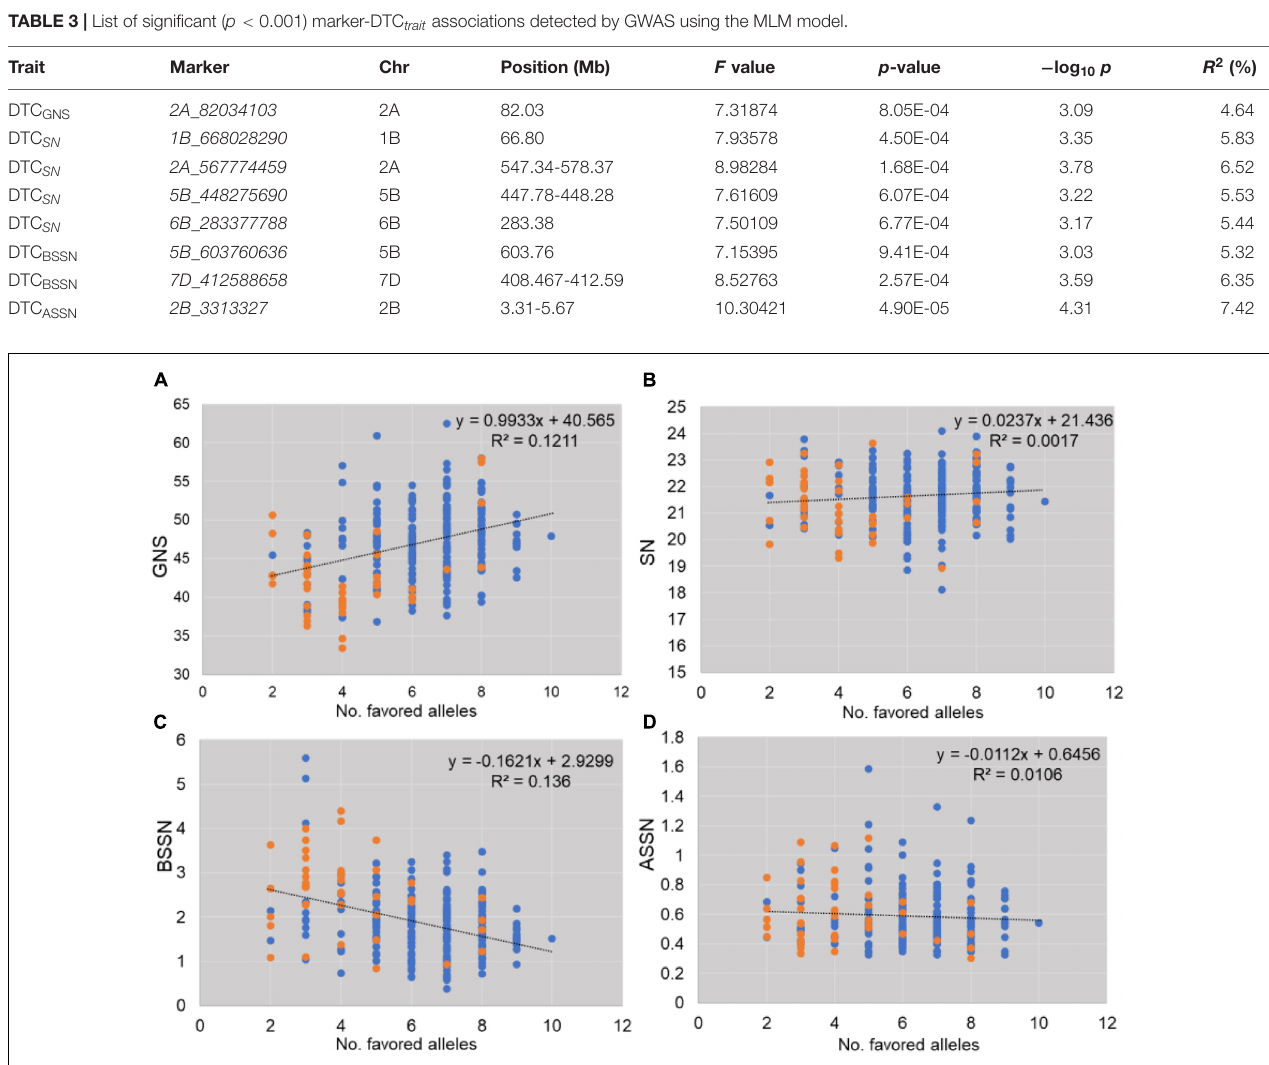
FIGURE 4 | Effects of favorable alleles estimated for traits studied ( A : GNS, B : SN, C : BSSN, D : ASSN). Blue spots indicate modern varieties and orange spots indicate landraces.